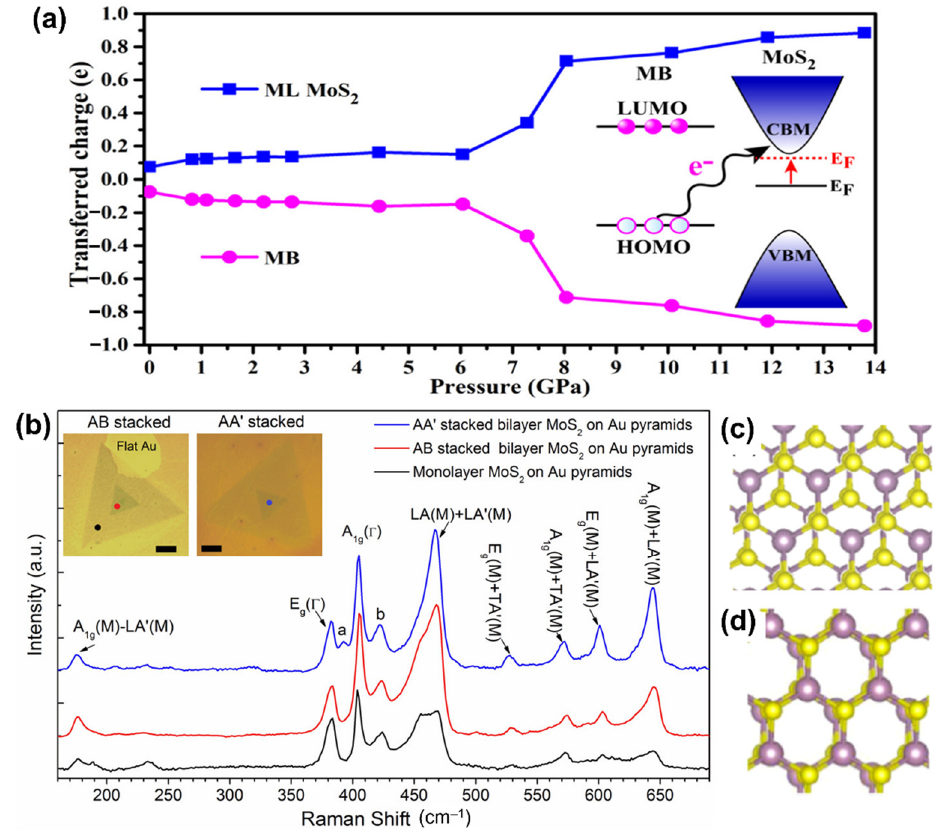
Figure 4. ( a ) Charge transfer at the monolayer MoS 2 (ML-MoS 2 )/methylene blue (MB) interface varies with pressure. The charge gained by ML-MoS 2 and the charge lost by MB molecules are set to be positive and negative, respectively. Reprinted with permission from ref. [76]. Copyright 2021 American Chemical Society. ( b ) Resonance Raman spectra of monolayer and bilayer MoS 2 on Au nanopyramids. Reprinted with permission from ref. [78]. Copyright 2015 American Chemical Society. Atomic structure diagram of ( c ) AB and ( d ) AA’ staked bilayer MoS 2 (purple balls represent Mo atoms, and yellow balls represent S atoms). Reprinted with permission from ref. [78]. Copyright 2015 American Chemical